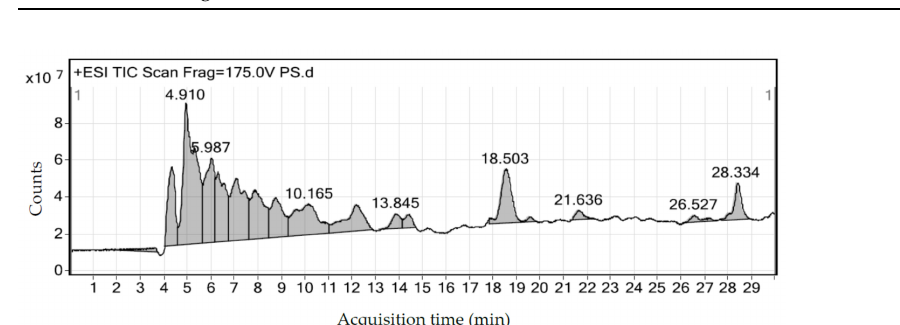
Figure 1. LC–MS analysis of E. tapos shell extract. The spectrum shows the compounds of E. tapos shell with retention time according to the chromatographic